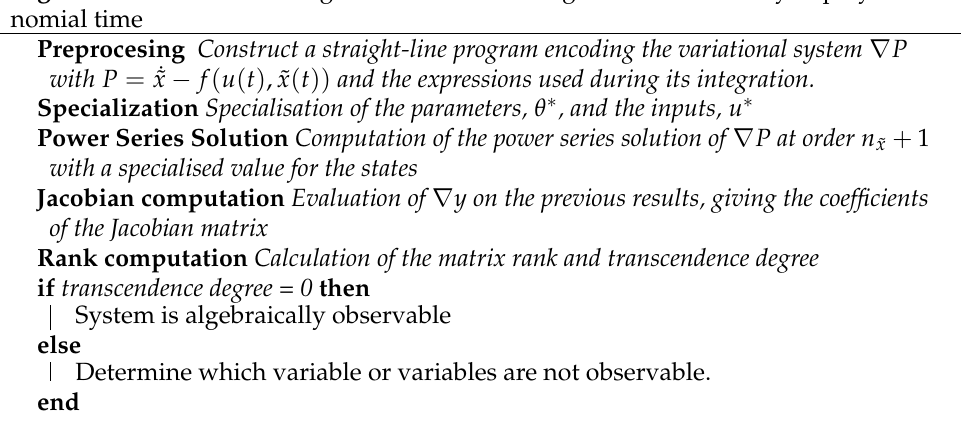
Algorithm 1: Probabilistic algorithm to test local algebraic observability in poly- nomial